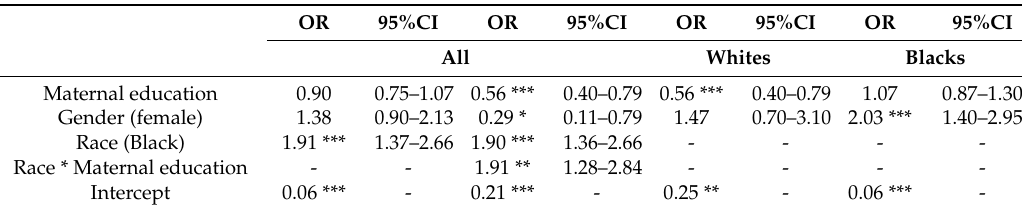
Table 3. The results of four logistic regression models in the pooled sample and across races on the separate effect of maternal education on subsequent SRH in the youths at age